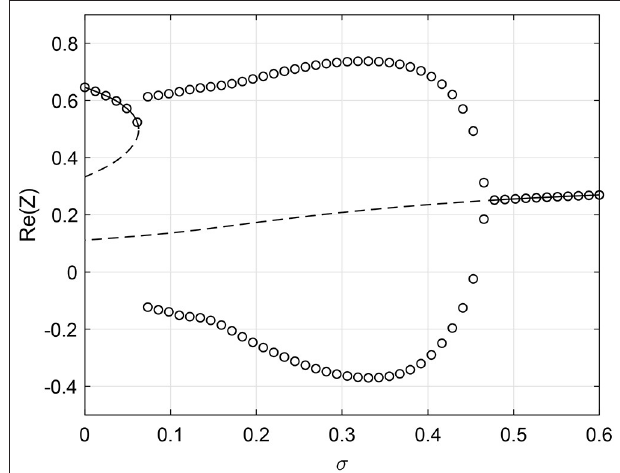
σ ( ˆ k out 1). Solid line: stable = +